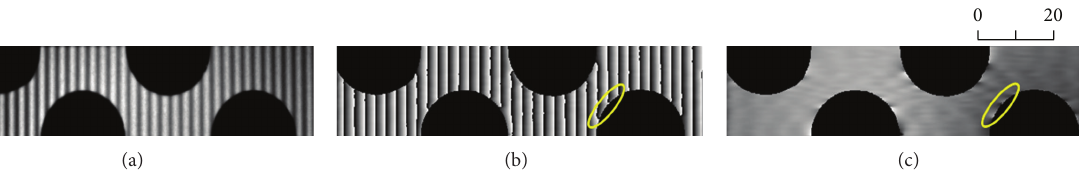
Figure 3: (a) Typical fringe pattern on a cantilever beam with irregular shape; (b) wrapped phase obtained by 2D spatial transform; (c) phase distribution after unwrapping and removal of the carrier.